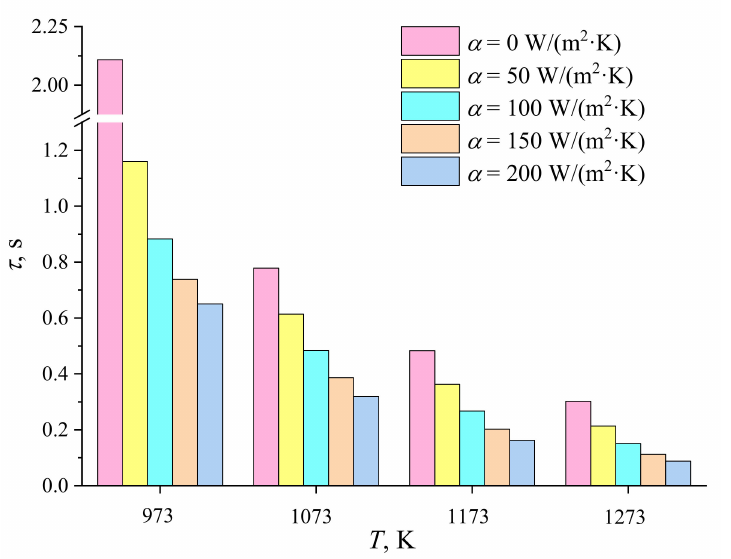
Figure 8. Theoretical dependency τ on T when varying the heat transfer coefficient α under convective heating